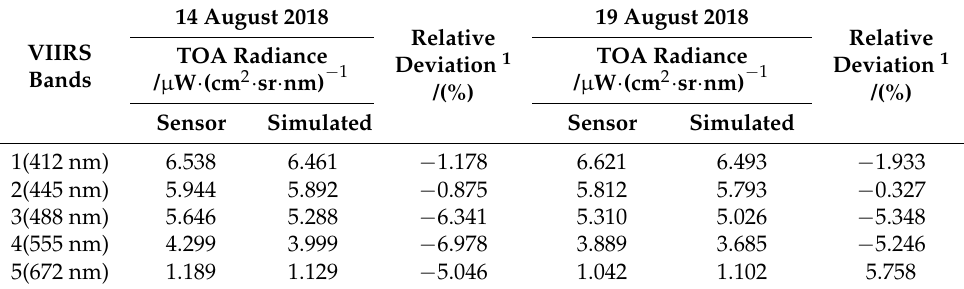
Table 7. Comparisons of TOA radiance between simulated and NPP/VIIRS measured.